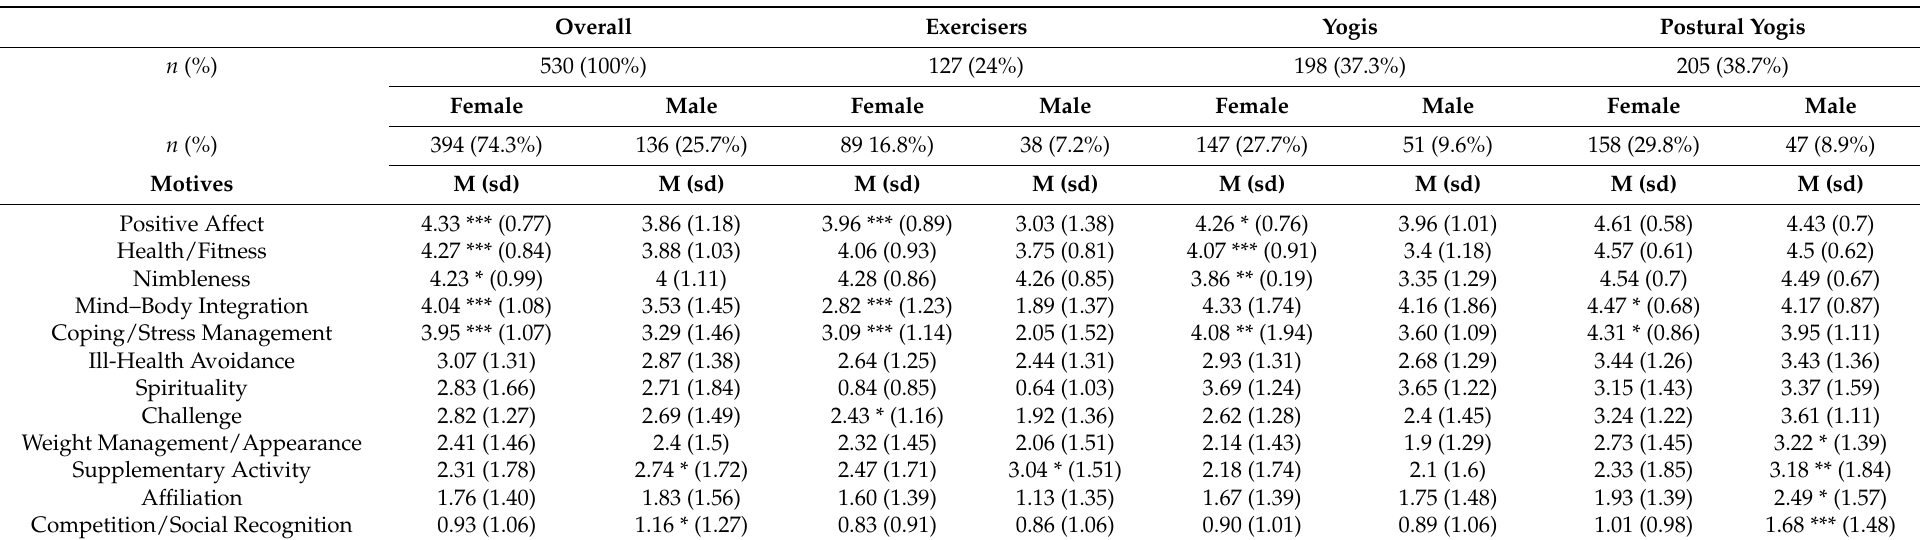
Table 2. Descriptive statistics of participation motives by gender and participant